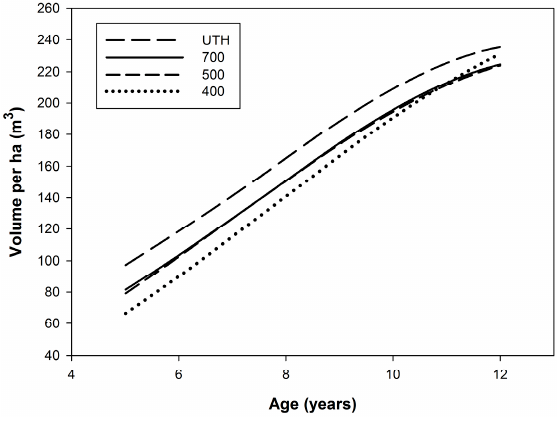
Figure 2. Standing volume curves by stocking treatment.